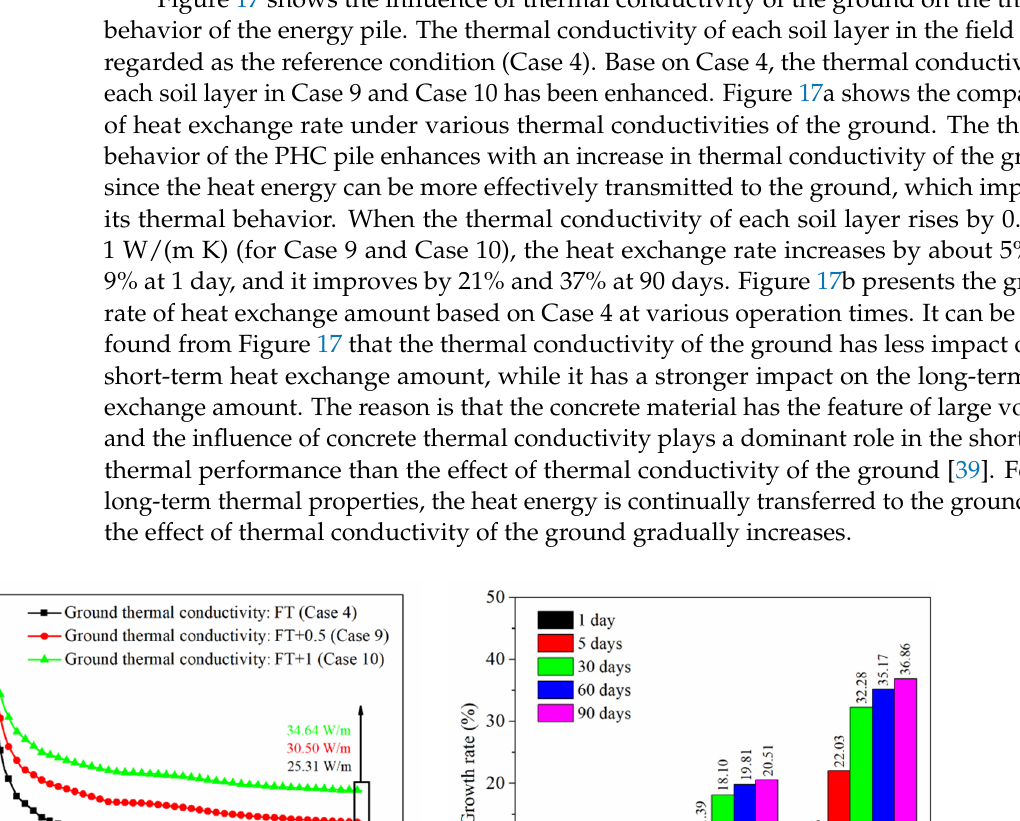
Figure 18. Effect of thermal conductivity of the ground on the ground temperature variation at 90 days (Units °C).